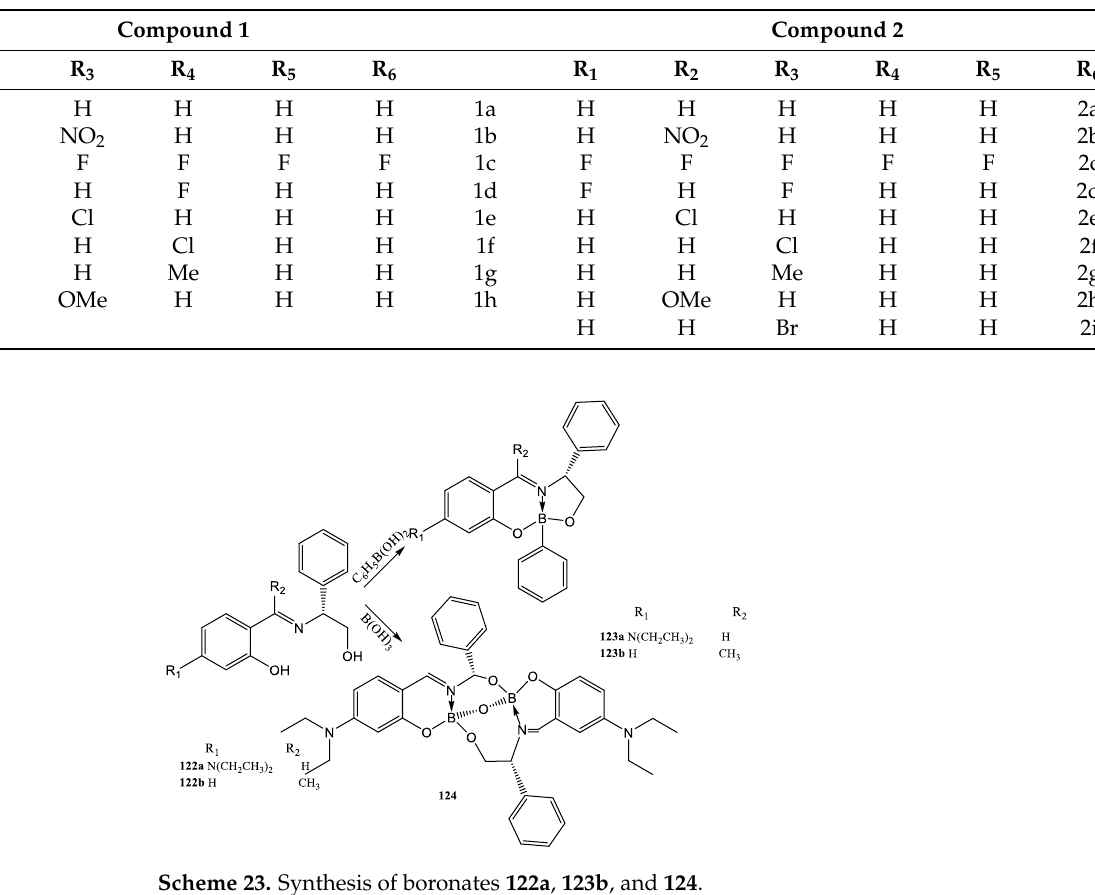
Figure 22. Structures of TMAB and TPhB.